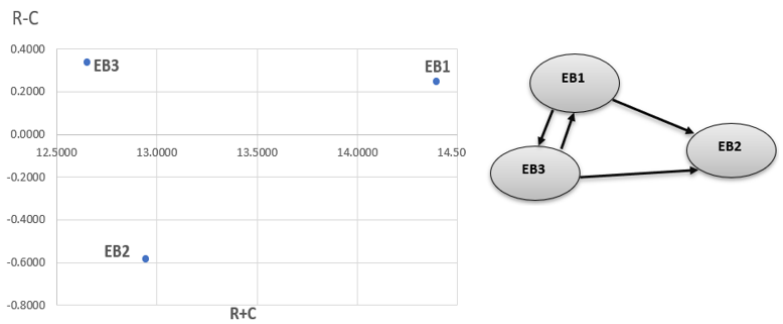
Figure A3. The causal effect graph for the environmental